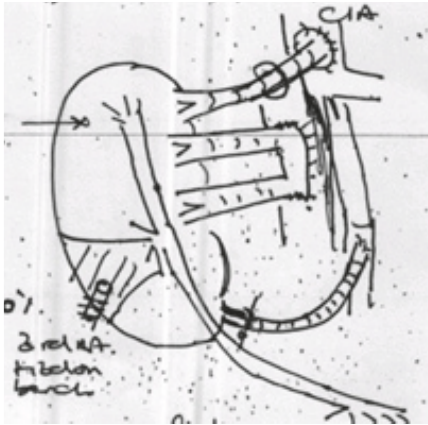
Figure 5: Drawing of the transplant showing ischemic area and all three vascular anastomoses.